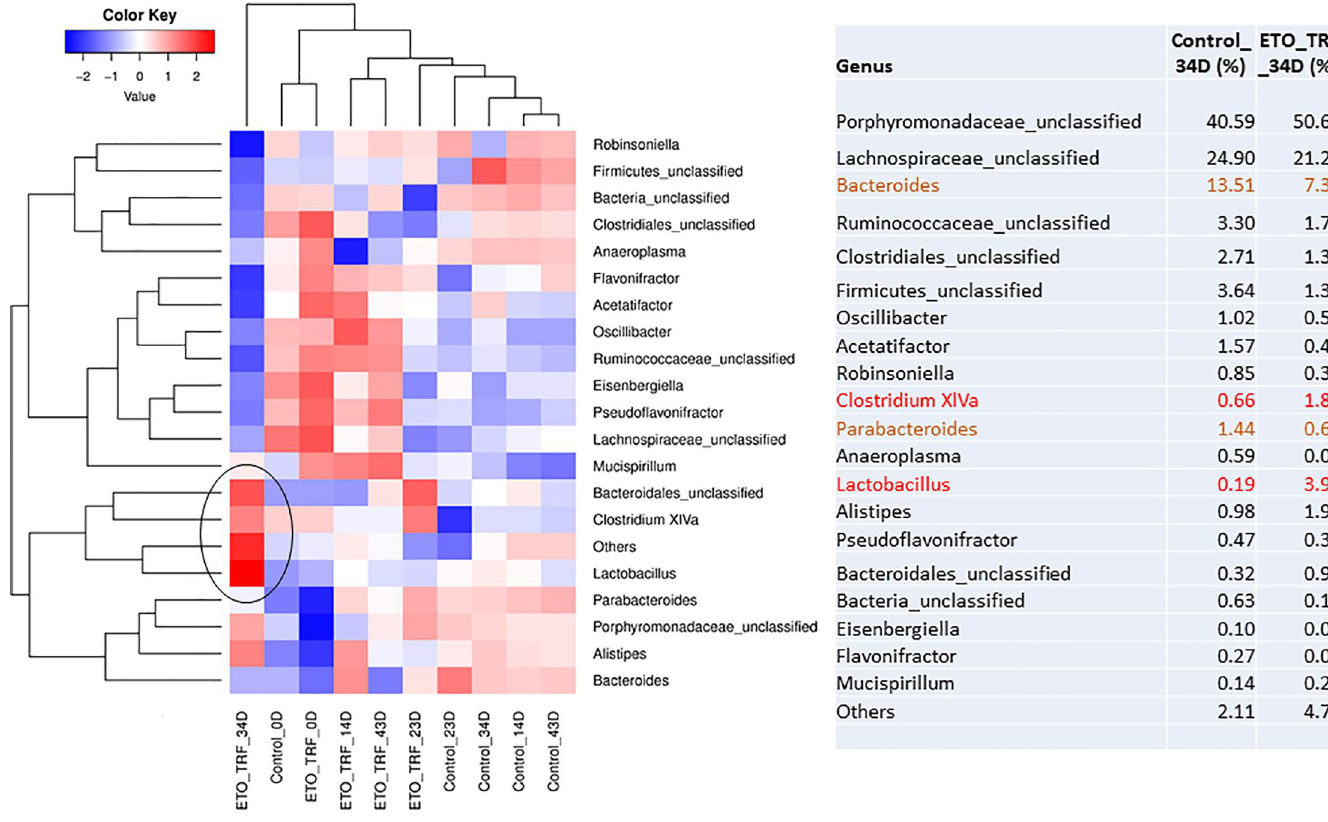
Fig 5. Heatmap showed the effect of ETO-Cur-TRF on relative abundance of microbial genus level in genomic DNA from mice feces. Red indicates high abundance and blue indicates less abundance. Marked increases in beneficial bacteria could be noted as indicated by red color after 34 days of ETO-Cur-TRF treatment. Black circle indicates increased abundance of specific microbial genus following ETO-Cur-TRF treatment.